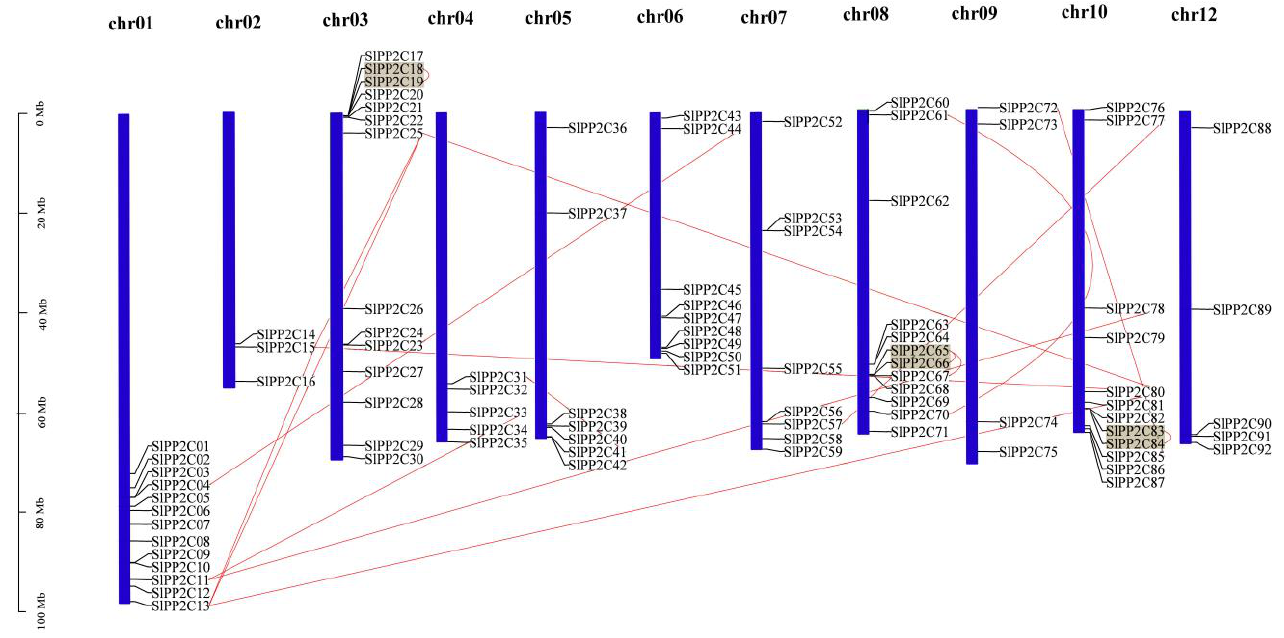
Figure 3. Chromosome distribution of tomato PP2C genes. Chromosome localization is based on the physical location (Mb) of 12 tomato chromosomes. Chromosome numbers are displayed at the top of each bar chart. Locations of tomato PP2C genes in chromosomes were obtained from the SGN (http://solgenomics.net accessed on 05 March 2022). Grey blocks were represented by the tandem duplicated genes, and the segmentally duplicated genes were linked by red lines. Scale bar on the left indicated the length (Mb) of tomato chromosomes.